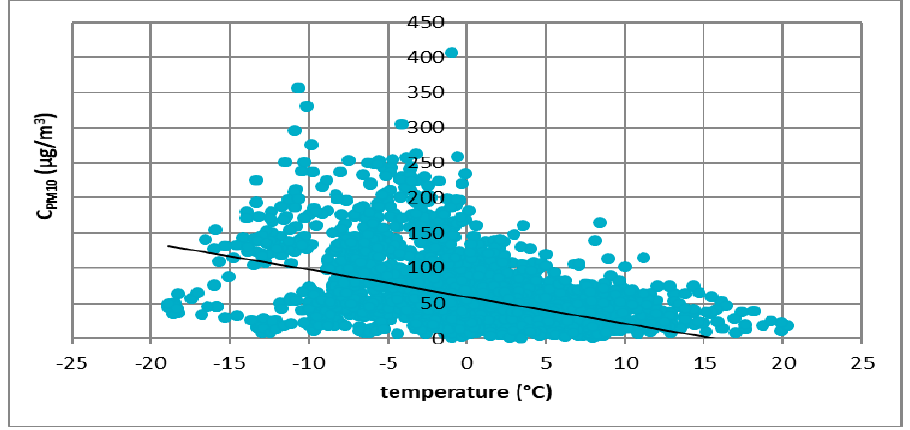
Figure 3. The effect of temperature on PM10 concentration in Ł ód ź in 2017.